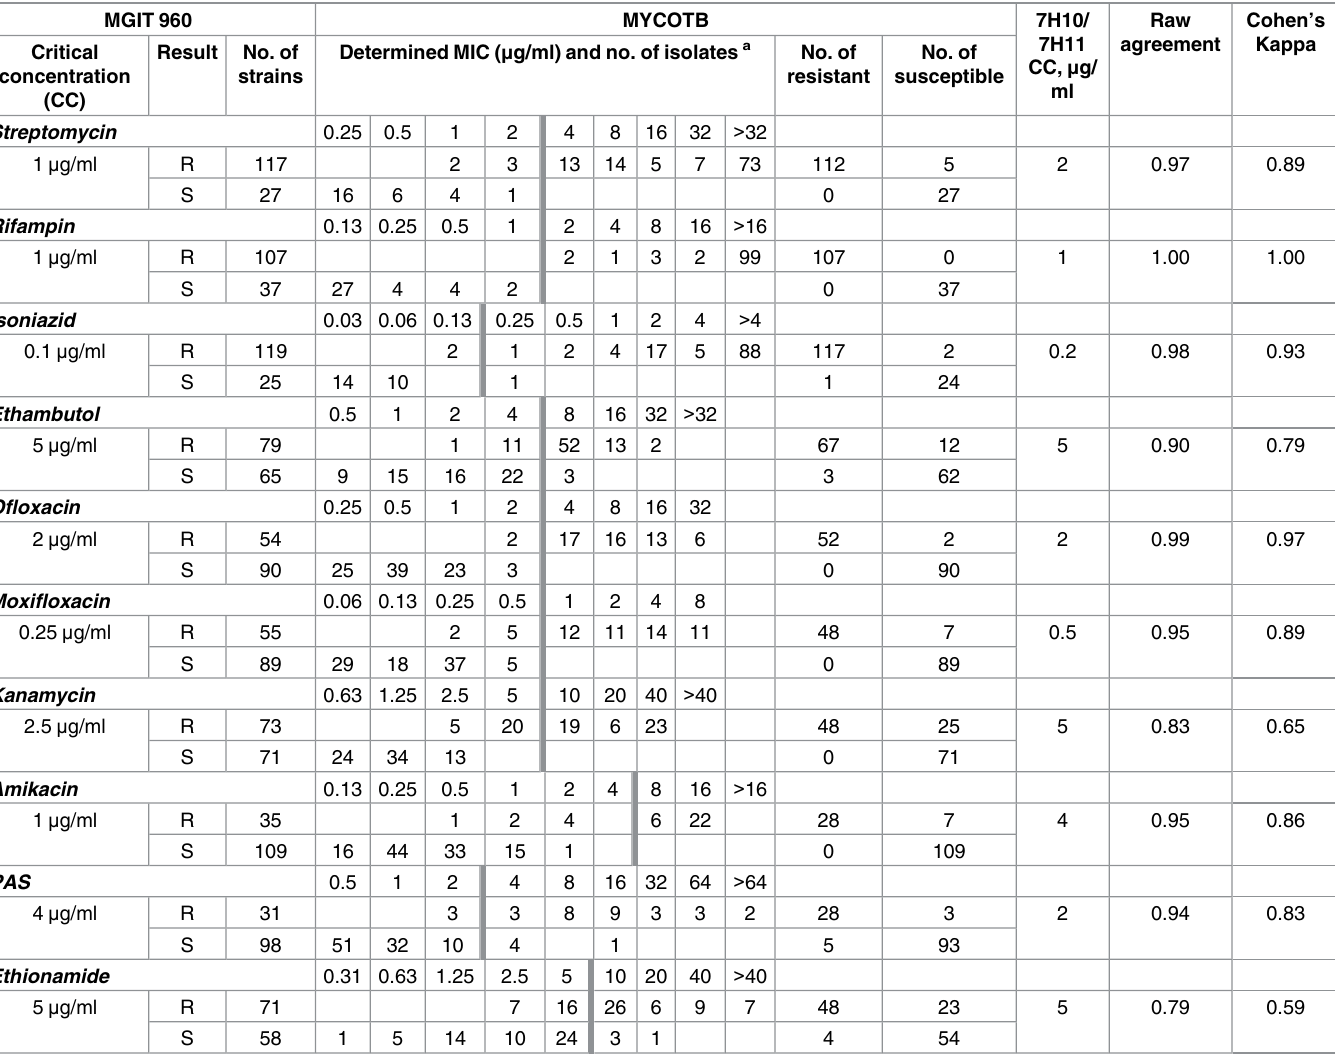
Table 2. MICs based on the comparison of the MycoTB plate and MGIT 960